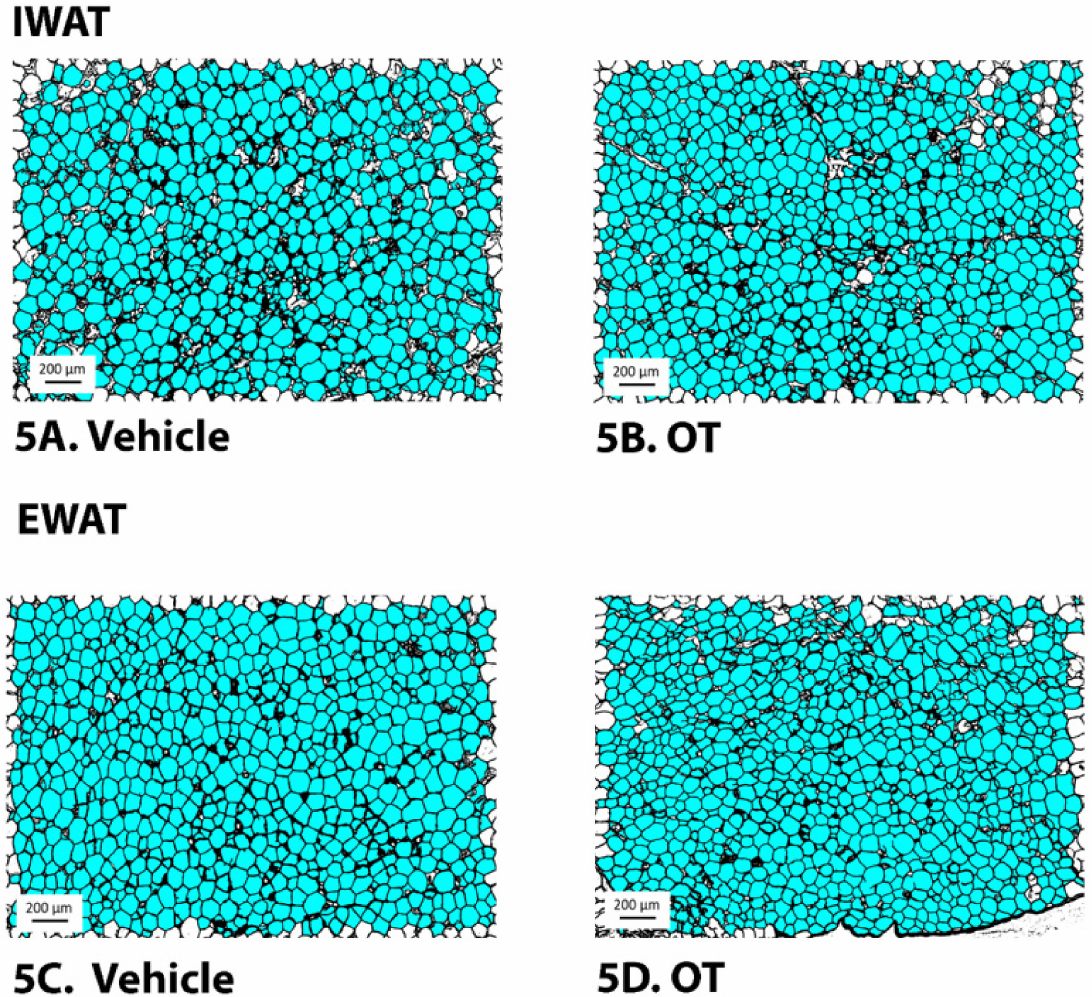
Figure 5. ( A – D ): Effect of chronic 4V OT infusions (16 nmol/day) on adipocyte size in IWAT and EWAT in male HFD-fed CD ® IGS rats. Adipocyte size was analyzed using ImageJ. Images were taken from fixed (4% PFA) paraffin-embedded sections (5 µ m) containing IWAT ( A , B ) or EWAT ( C , D ) in HFD-fed rats treated with 4V OT (16 nmol/day) or 4V vehicle. ( A ), Veh (IWAT). ( B ), OT (IWAT). ( C ), Veh (EWAT). ( D ), OT (EWAT); ( A – D ) all visualized at 100 ×